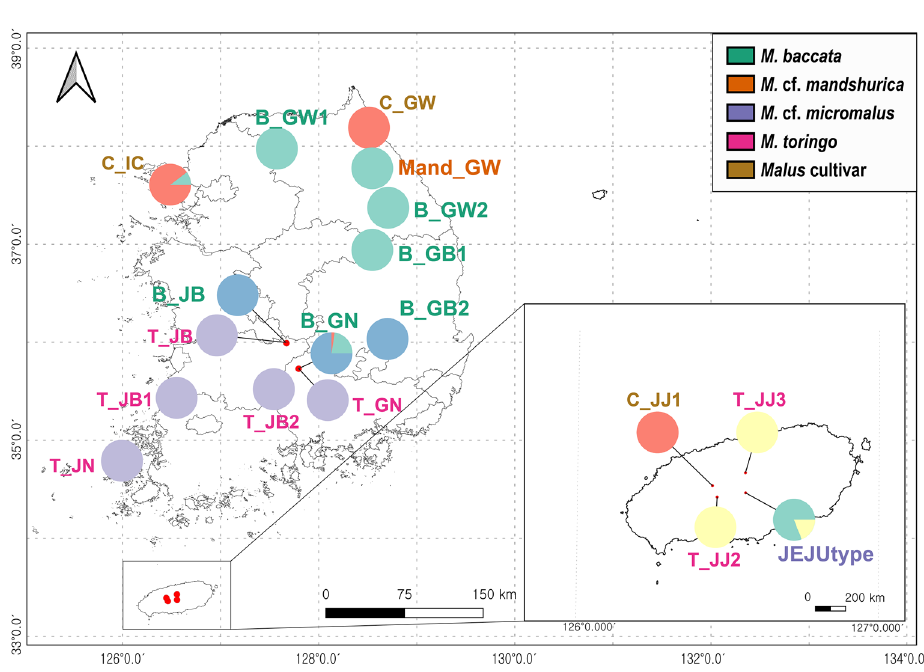
Figure 6. Pie charts of the location map used for the genetic population structure analysis of 18 Malus populations. The pie charts show the frequency of each cluster in a population based on STRU CTU RE results (K = 5). Map source: https:// www. gisde velop er. co.